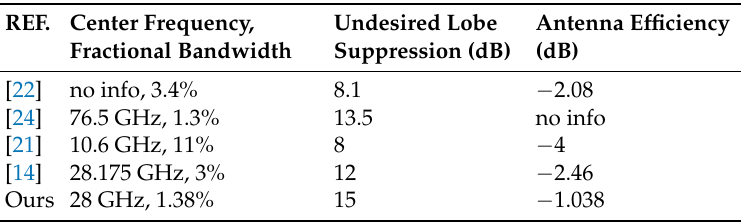
Table 1. Comparison of performances with related